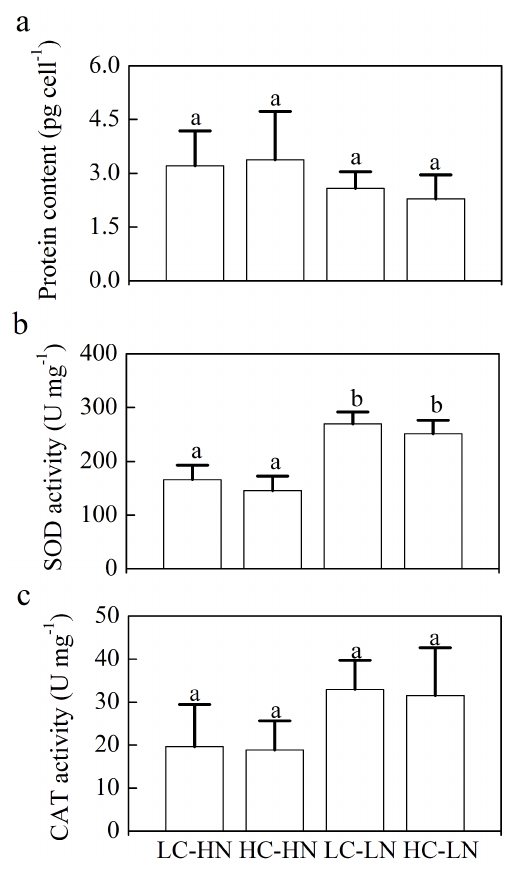
Figure 5. Protein contents, SOD and CAT activities of P. tricor- nutum under different treatments. (a) Protein contents, (b) SOD and (c) CAT activities (represented as per milligram protein) of P. tricornutum grown at ambient (390µatm, LC) or elevated CO 2 (1000µatm, HC) under NO − -replete (110µmolL − 1 , HN) or NO − - 3 3 limited (10µmolL − 1 , LN) conditions. The different letters above each column indicate significant differences between different treat- ments at P< 0 . 05 level. Vertical bars show mean ± SD, except the CAT value in HC–LN for which there were only two replicates, other treatments used at least three replicates ( n =